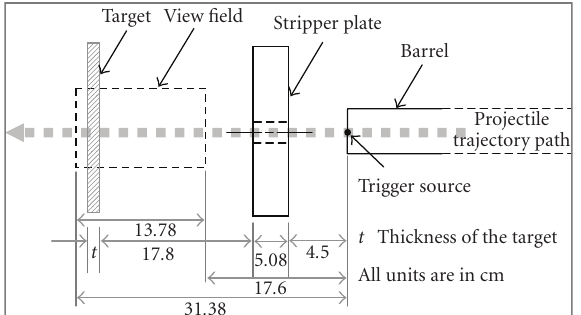
Figure 2: Experimental setup of gas gun with high-speed